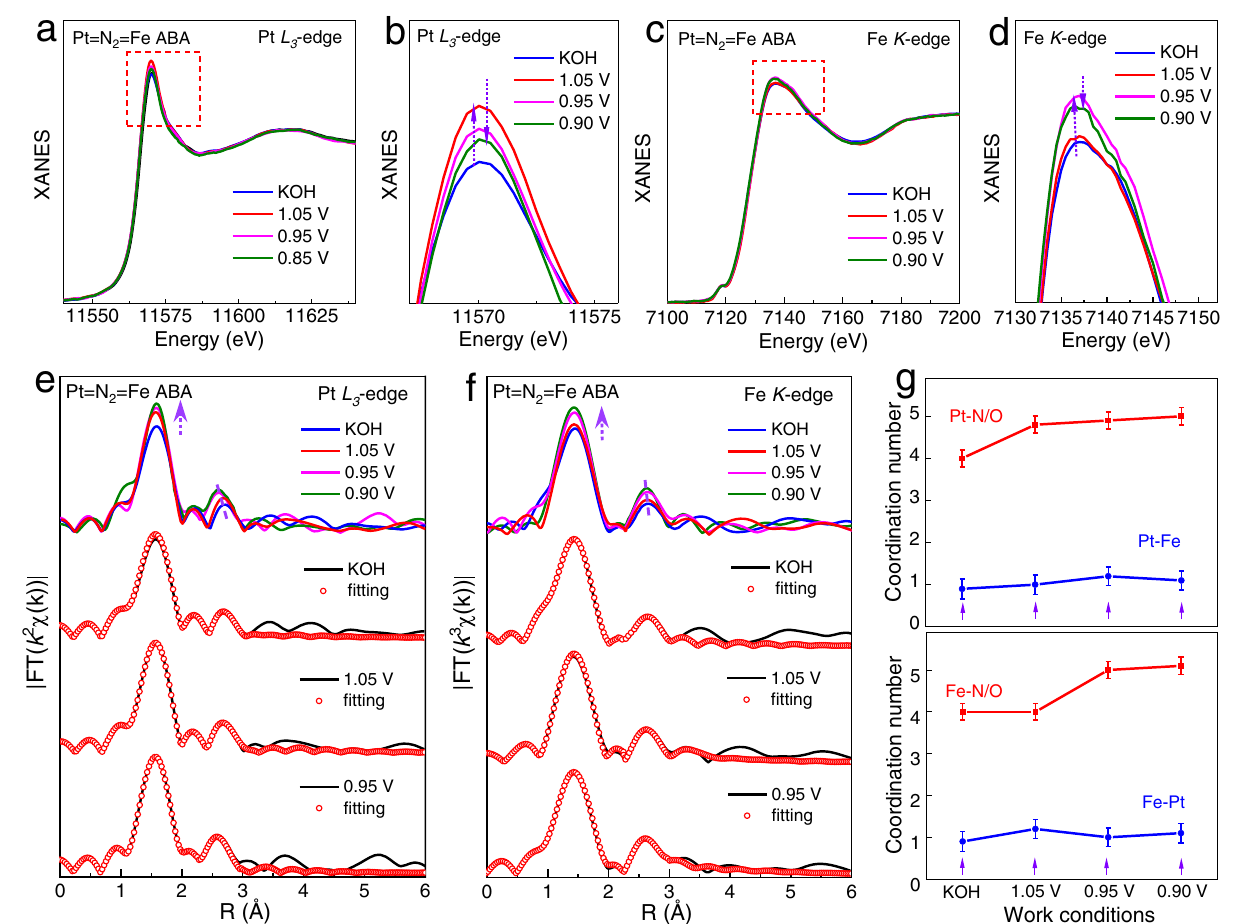
Fig.3|Thestructureevolutionidenti fi edbyinsituXAFS.a – d ThePt L 3 -edge( a ) and Fe K -edge ( c ) XANES spectra, and b , d are the corresponding local magni fi ca- tions of the white-line peaks. e , f The Pt L 3 -edge ( e ) and Fe K -edge ( f ) FT-EXAFS